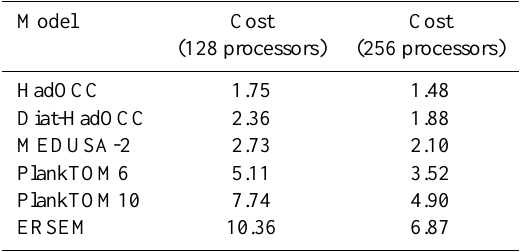
Table 4. Computational cost of each candidate model when coupled to the ocean component of HadGEM3, relative to a physics-only simulation with the same ocean model (ORCA1.0L75). A cost of 2 indicates that adding the biogeochemistry model doubles total sim- ulation cost. Timings are shown for simulations carried out on 128 and 256 processors of an IBM Power7